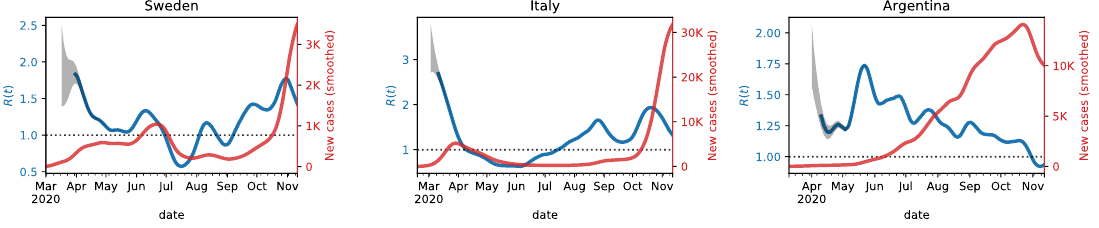
Figure 1. ( t ) estimated with the proposed method from the time series of new daily cases reported in Sweden, Italy, and Argentina. Red curves are reported incidence rates, and the blue curves the reconstructed reproduction numbers.